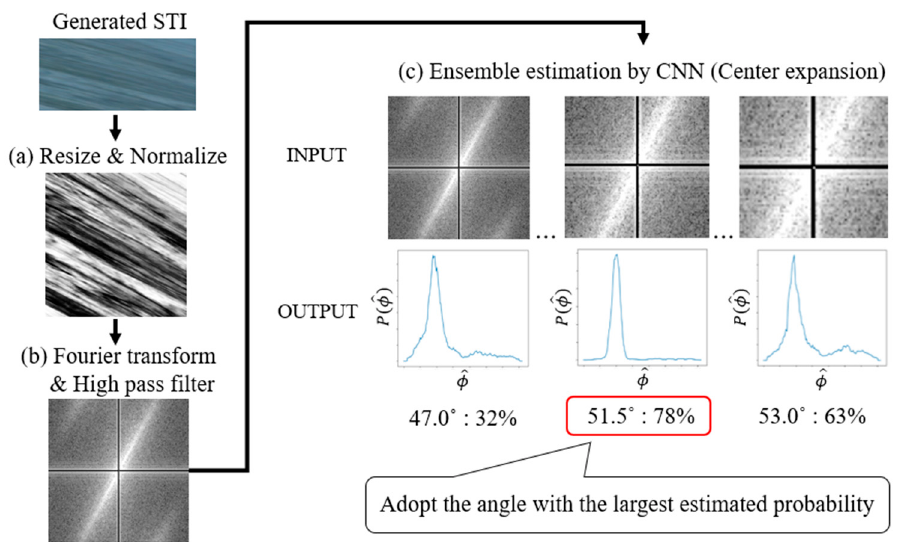
Figure 5. Process flow of STI pattern gradient detection by Convolutional Neural Network (CNN): ( a ) The generated STI is resized and normalized; ( b ) A 2D Fourier transformation is performed and a high-pass filter is applied; ( c ) Ensemble CNN estimation is performed using multiple images with the center of the image magnified.